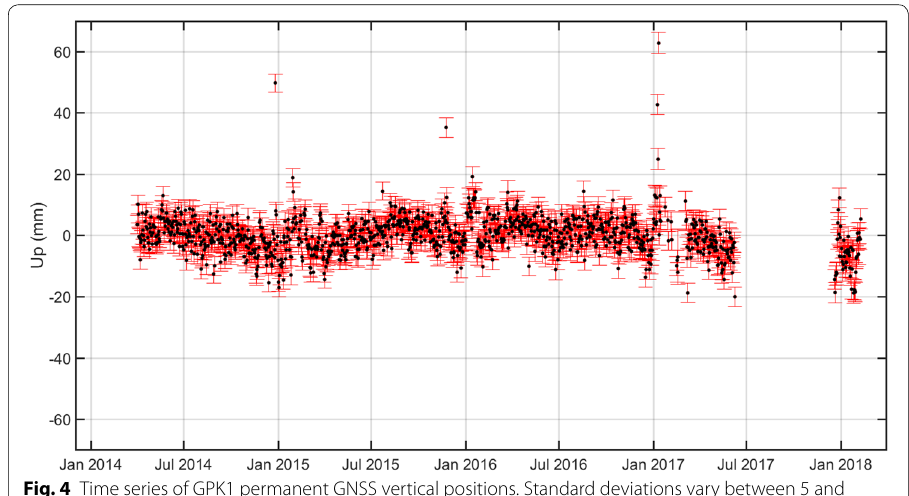
Fig. 4 Time series of GPK1 permanent GNSS vertical positions. Standard deviations vary between 5 and 10 mm (From RéNaSS